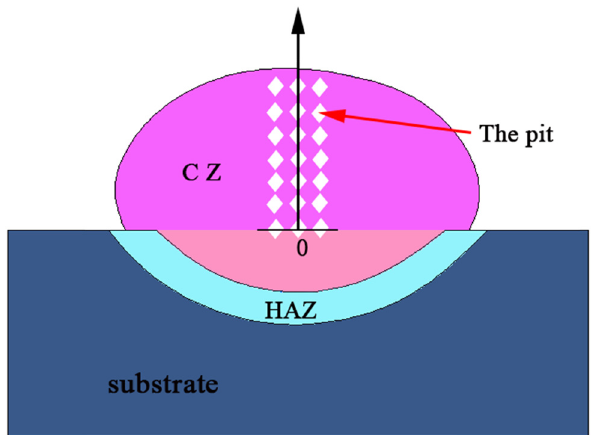
Figure 14: Schematic of CZ hardness.